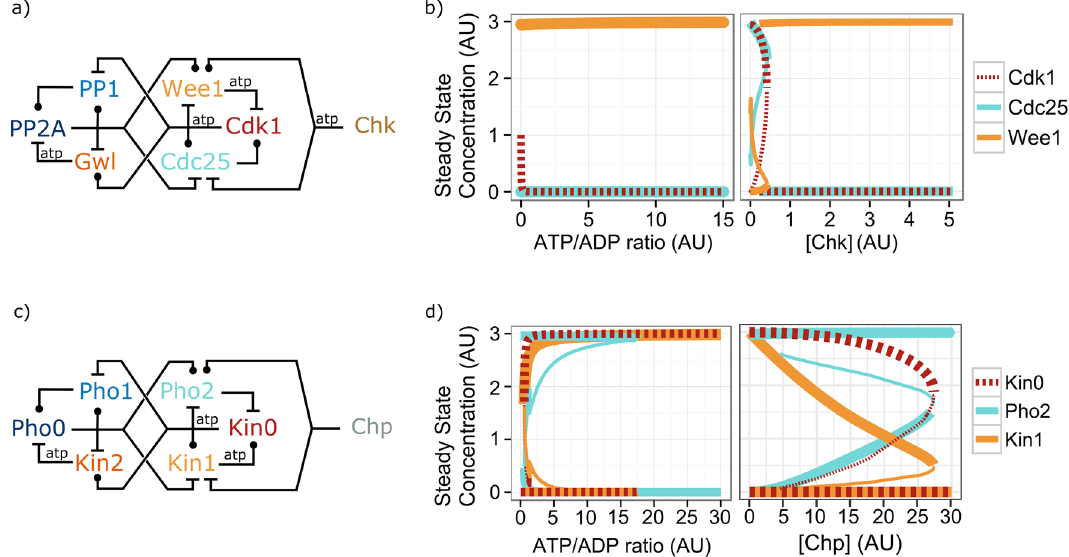
Figure 3. Arresting the entry into mitosis through checkpoint kinases. ( a ) Wiring diagram of the mitotic network controlled by the checkpoint kinase Chk. Blue palette indicates the phosphatases. Orange palette shows the kinases. Ball-end edges indicate activation; dash-end edges indicate inhibition. atp labels the edges that require a source of phosphate. ( b -left) Bifurcation diagram of the steady-state concentration when the ATP/ADP ratio controls the system but Chk parameter is set at 0.5 (AU) ( b -right) Bifurcation diagram of the steady-state concentration of the core cell cycle controllers with Chk as an external parameter and the ATP/ADP ratio is set to 8 (AU), which was enough to drive the cells into mitosis in the absence of Chk (Fig. 2). ( c ) Wiring diagram of the GKP system interacting with an external phosphatase through Pho2 and Kin1 (Chp-GKP system). Blue palette indicates the phosphatases. Orange palette labels the kinases. Ball-end edges indicate activation; dash-end edges indicate inhibition. atp labels the edges that require a source of phosphate. ( d -left) Bifurcation diagram of the steady-state concentration when the ATP/ADP ratio drives the system and the Chp parameter is set at 0.5 (AU). ( d -right) Bifurcation diagram of the steady-state concentration when Chp controls the system and the ATP/ADP ratio is set to 8 (AU). See supplementary methods for details of the simulations. R version 3.6 and ggplot2 37,38 was used to create the